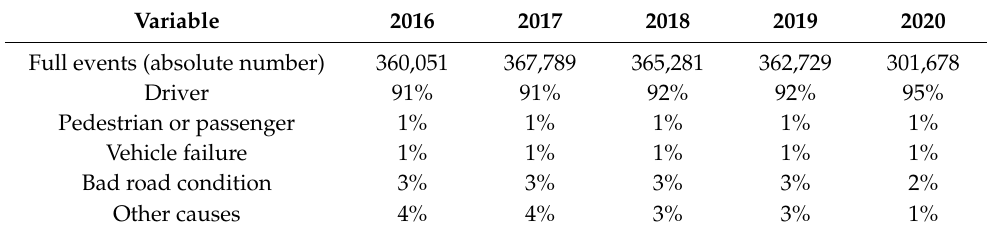
Table 1. Report by INEGI: causes of land traffic accidents in urban/suburban areas in